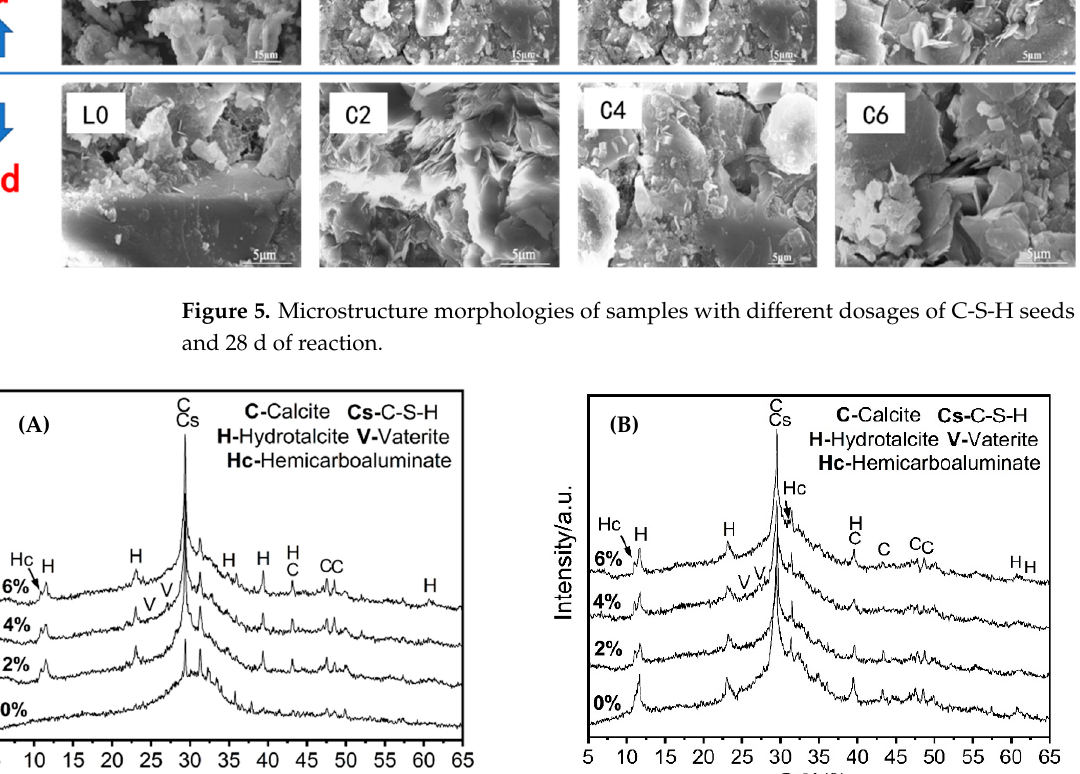
Figure 5. Microstructure morphologies of samples with different dosages of C-S-H seeds after 1 d and 28 d of reaction.